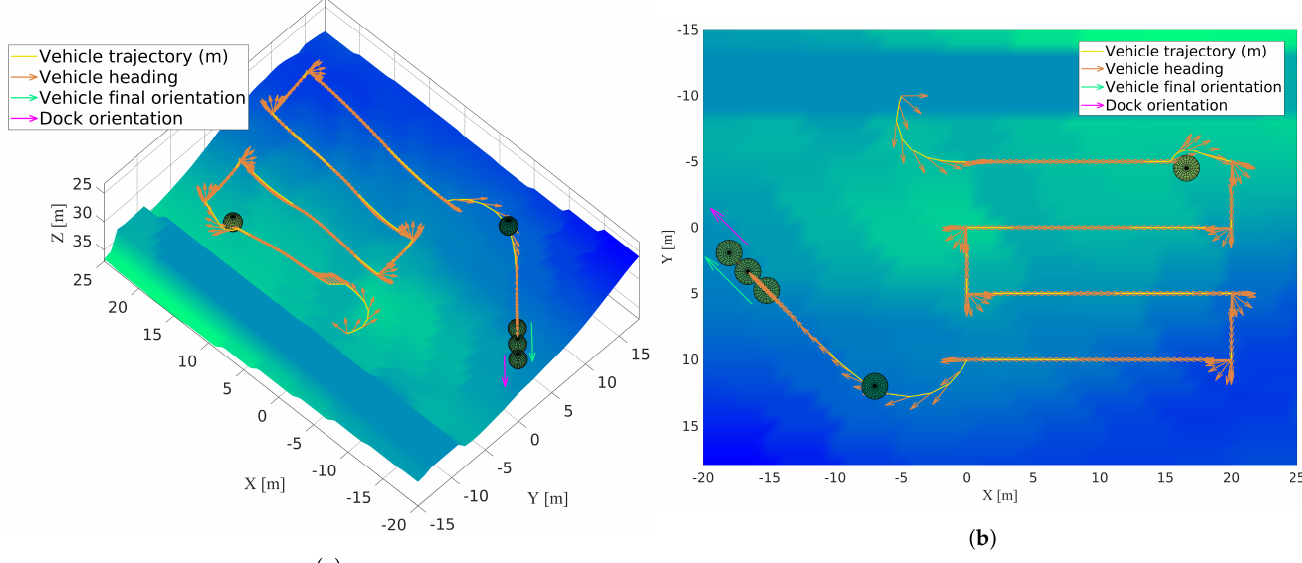
Figure 16. Constant altitude mission: Plot showing the mission and docking to a moving docking station situated close to the seafloor ( a ) in the 3D space ( b ) from top